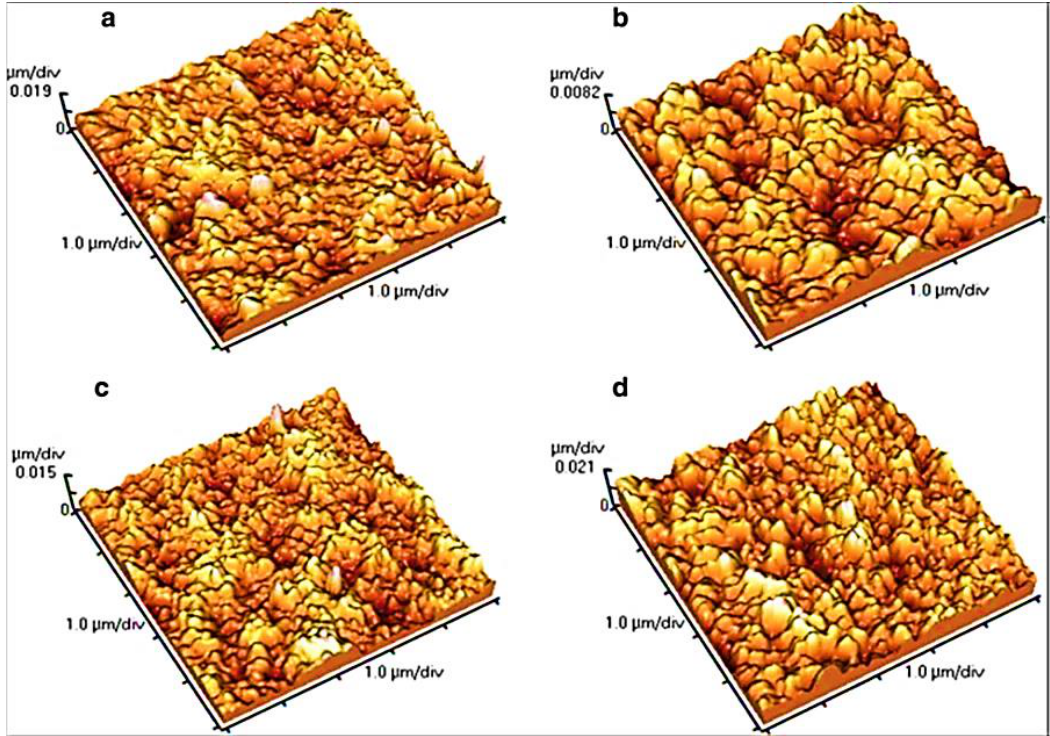
Figure 11. AFM three-dimensional surface morphology of prepared membranes ( a ) pure PSF; ( b ) PSF/GO 0.5; ( c ) PSF/GO 1; ( d ) PSF/GO 2 membranes [139]. PSF — polysulfone; PSF/GO — polysulfone/graphene oxide; AFM—atomic force microscopy. Reproduced with permission from [139]. Copyright 2015 Springer.